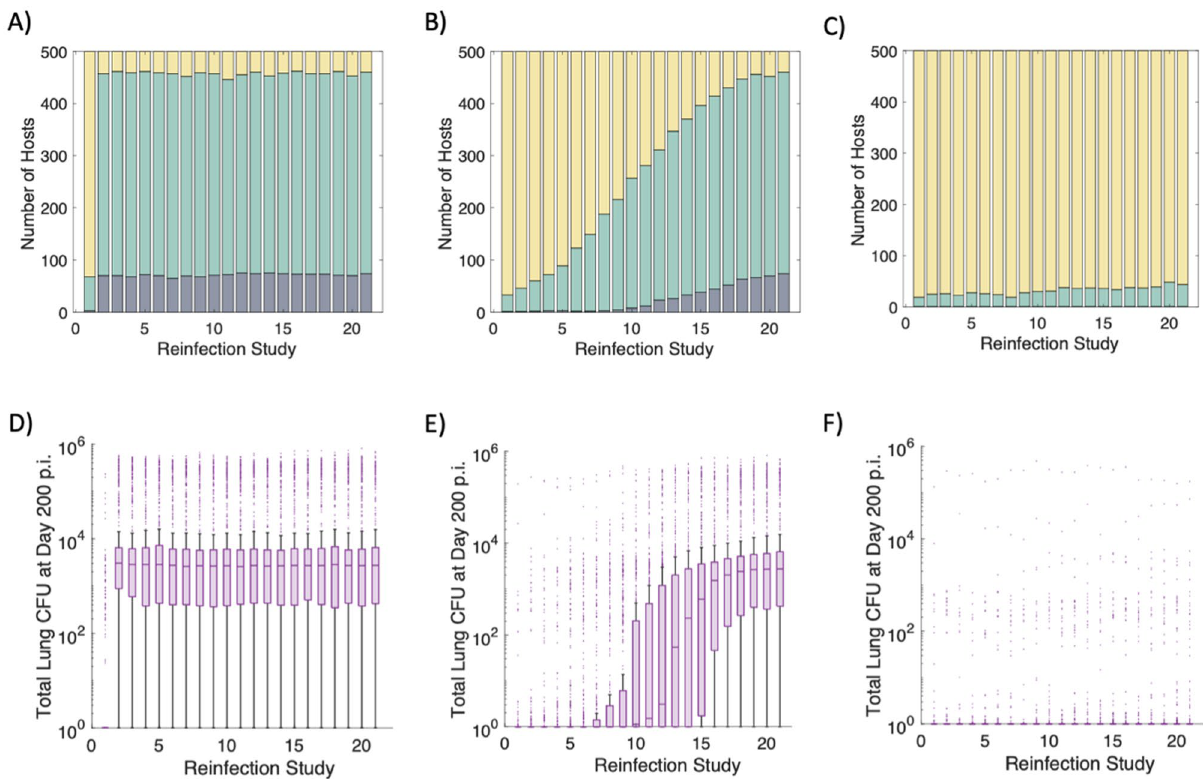
Figure 2. Clinical classifications and total lung CFU across three sets of virtual reinfection studies. Clinical classifications for 500 virtual hosts across 21 separate reinfection studies when the lifespan of Trms is varied from 33 days, 833 days, or 10,000 days ( d Trm = 0.03, 0.0012, or 0.0001 cells/day) ( A , B , C , respectively). Each stacked bar chart shows the breakdown of active TB (dark blue), LTBI (green) or Mtb eliminator (yellow) hosts for each reinfection study. Clinical classifications are determined according to total lung CFU 200 days after reinfection. Box-and-whisker plots show the distribution of total lung CFU across the 500 virtual hosts for each reinfection study when d Trm = 0.03, 0.0012, or 0.0001 cells/day ( D , E , F ,